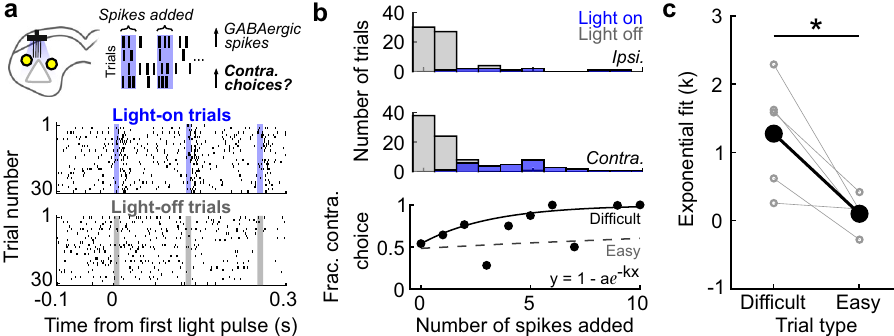
Fig. 5 Contralateral choice is more likely on trials in which light elicits more spikes in GABAergic SC neurons. a Schematics of experimental set-up and analysis, and rasters for an example contralateral-preferring GABAergic neuron recorded in a stimulation/behavior/recording session, aligned to fi rst light pulse separately on contralateral light-on and light-off trials. Shading indicates the timing of light pulses on light-on trials. b Histograms show number of ipsilateral and contralateral choices as a function of number of spikes during time of light delivery on light-on trials and matched time on light-off trials. Circles show fraction of contralateral choices for each number of spikes added. Solid line, best- fi t exponential function to raw trial-by-trial values (ipsilateral choice = 0; contralateral choice = 1) for dif fi cult trials (% Ipsi. odor = 40, 50, or 60). Dashed line, same fi t for easy trials (% Ipsi. odor = 5, 20, 80, or 95). c For each GABAergic neuron with a signi fi cant contralateral choice preference recorded in stimulation/behavior/recording sessions ( n = 5), slope of exponential fi t ( k ) is plotted for dif fi cult and easy trials (* p = 0.027, two-tailed paired t -test). For this analysis neurons were included in our GABAergic population if they responded within 7 ms of photostimulation (Methods). Large symbols show population